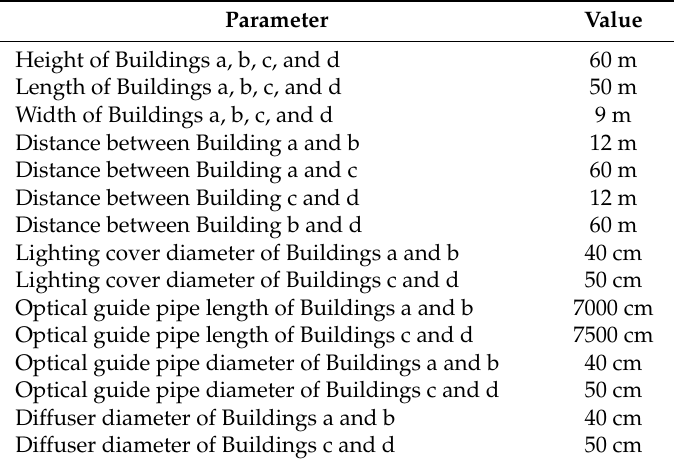
Figure 2. Schematic of the building group, the SOGL system and the distribution of light sources at different times in Changzhou, China (32 ◦ N, 120 ◦ E), where red suns show the time of day. Table 1. Dimensions of the buildings and configuration sizes of the SOGL system.